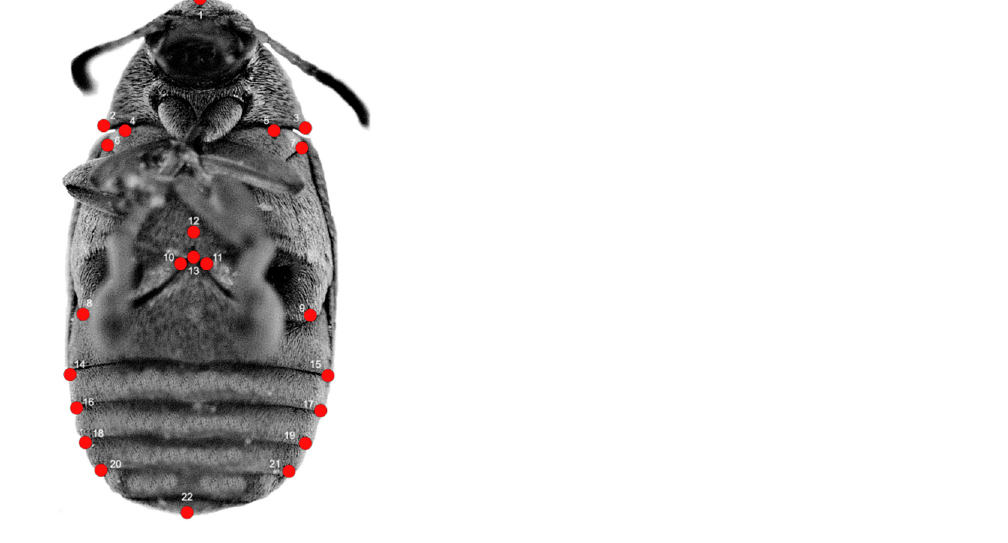
Figure 1. Landmark configurations on Acanthoscelides obtectus example. See Table 1 for landmark definitions.